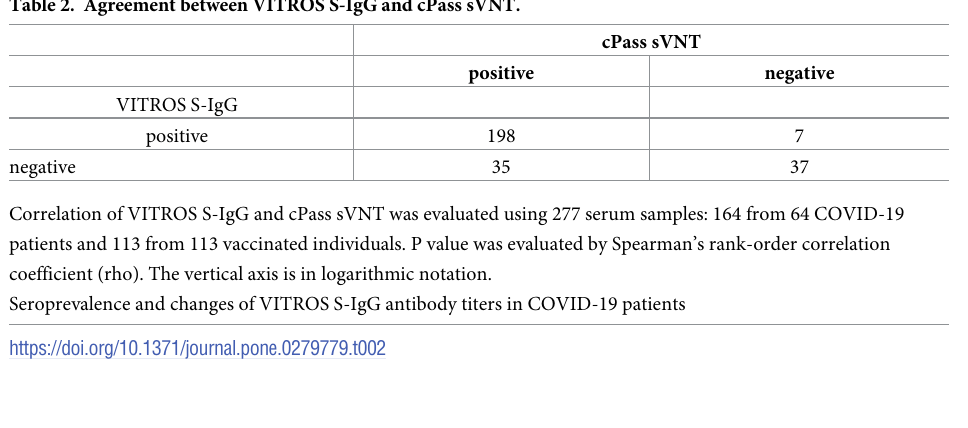
Table 2. Agreement between VITROS S-IgG and cPass sVNT.